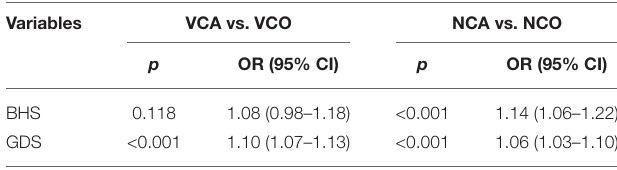
TABLE 3 | Comparison of suicide behaviors of suicide cases via violent and non-violent suicide methods.